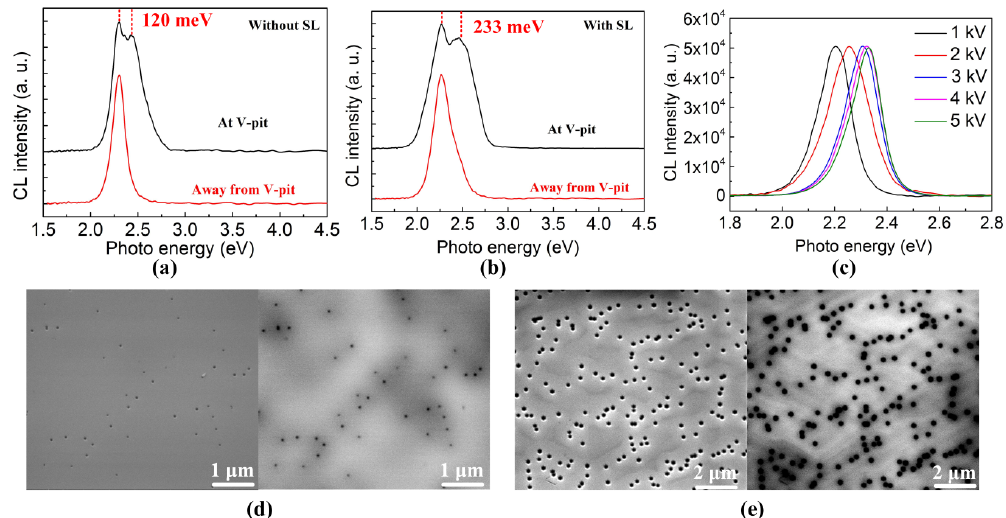
Figure 3. CL spectra measured from a green InGaN/GaN MQW ( a ) without an InGaN/GaN SL; and ( b ) with an InGaN/GaN SL at an acceleration voltage of 2 kV; ( c ) Depth-resolved CL spectra of the green InGaN/GaN MQW measured at various acceleration voltages. The SEM and CL images taken from the same area of the samples ( d ) without an InGaN/GaN SL; ( e ) with an InGaN/GaN SL. Figure 4a,b show the cross-sectional HAADF-STEM images of a green In 0.25 Ga 0.75 N/GaN MQW grown on an In 0.04 Ga 0.96 N/GaN SL, where the V-pits connecting with TDs extend from the underlying SL and pass through the MQW to the low temperature p-GaN and p-AlGaN electron blocking layer. We found that large V-pits start to form at the last few SL pairs while small V-pits form at the first few quantum well pairs. Besides this, it was interesting to observe in Figure 4b that two adjacent V- pits merged and formed a wider W-defect section. A plan-view TEM analysis was performed to confirm the distribution of V-pits on the epilayer by bright-field imaging in the vicinity of the (0001) zone axis. Figure 4c shows the plan-view TEM images of a portion of a green LED epitaxial layer, including the low temperature p-GaN layer, the InGaN/GaN MQW, and a portion of the n-GaN layer along the (0001)-growth direction. The plan-view TEM images associated with selected area diffraction (SAD) patterns confirm that the V-pits were projected along (0001), and each side of the hexagon corresponds to intersections of the (0001) and (10-11) planes.